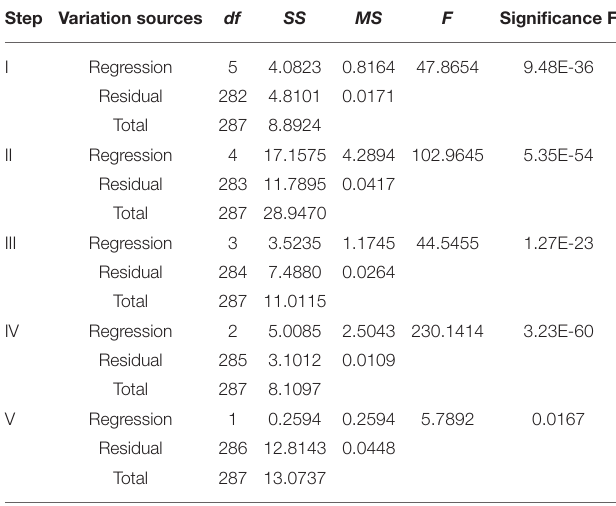
TABLE 1 | The ANOVA results of regression models for incidence